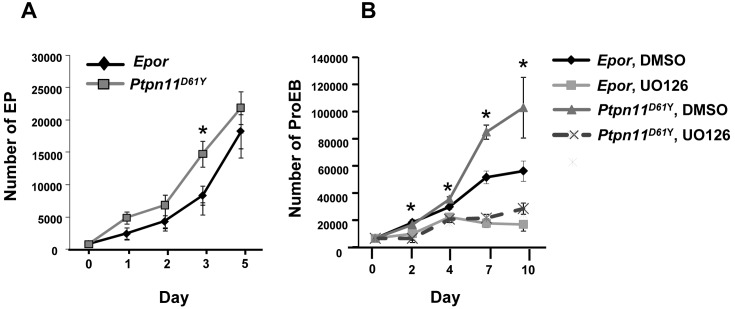

Ptpn11D61Y erythroid progenitors show defective differentiation in

vitro
. (A) BM-derived Lin−cKIT+ cells from Epor and Ptpn11D61Y mice were FACS-purified and cultured in serum-free StemEx medium for 5 days, as described in Materials and Methods. Absolute numbers of cells were determined daily. The average number of cells from four independent experiments is shown. *p≤0.05, ANOVA. (B) Lin−cKIT+ cells from Epor and Ptpn11D61Y mice were FACS-purified and cultured in serum-free StemEx medium 7 days. Equal numbers of cells were expanded in StemEx medium for another 10 days in the presence of UO126 or DMSO. The average number of cells from three independent experiments is shown. *p≤0.05, ANOVA.